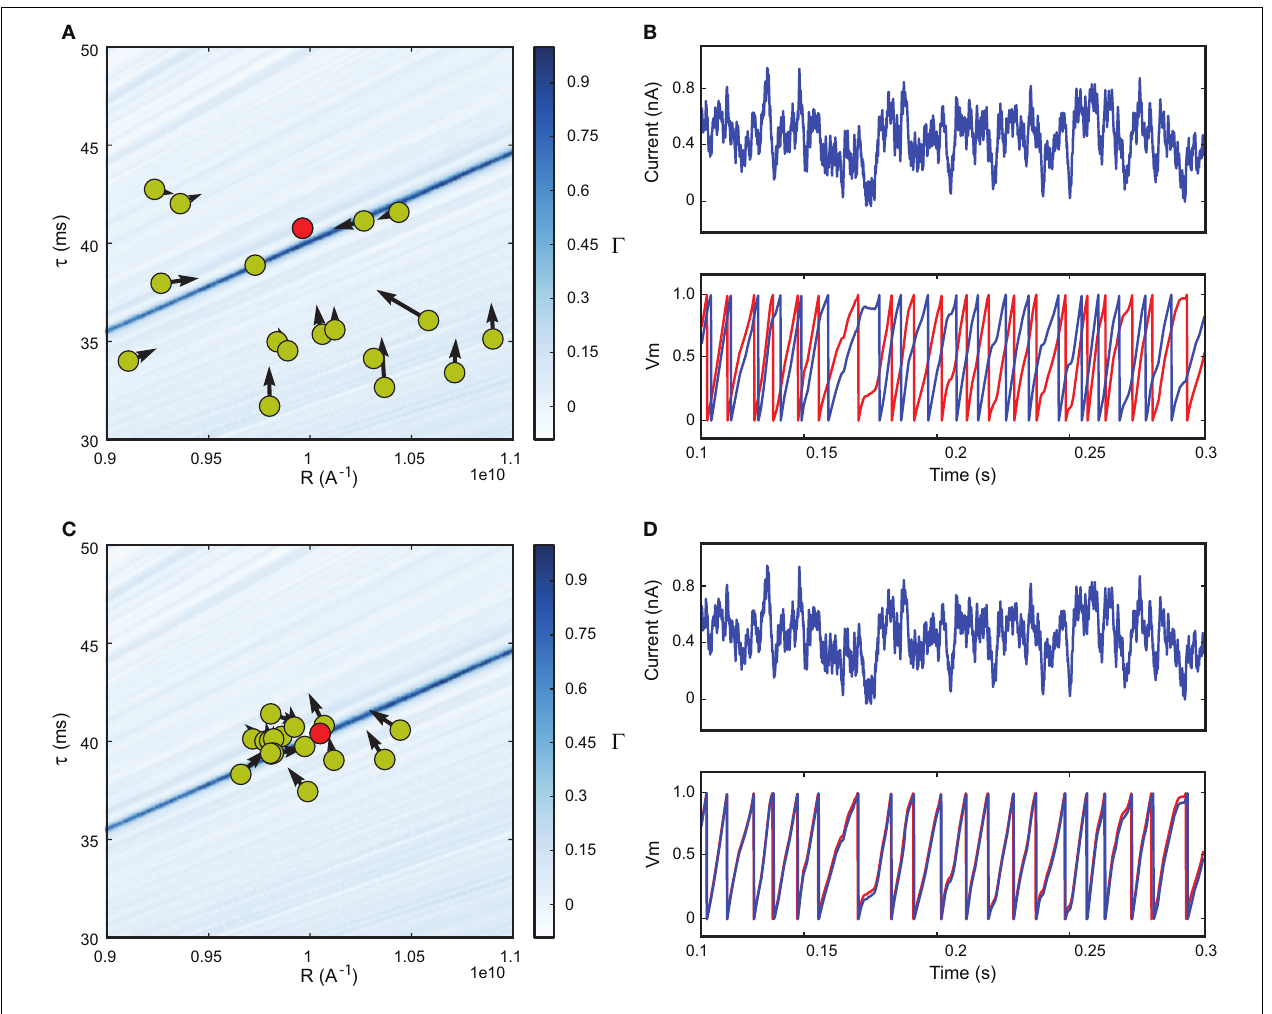
FIGURE 1 | Fitting spiking neuron models with particle swarm optimization (PSO). The target spike train was generated by injecting a noisy current (white noise, 500 ms long) into a leaky integrate-and-fi re model ( R = 10 10 A − 1 and τ = 40 ms), and PSO was run to fi nd the correct parameter values. The boundary conditions used for the optimization are the ranges of the axes. The optimization algorithm makes the particles (sets of parameter values) evolve towards the area with high fi tness values (an oblique line in this example). (A) Positions of the